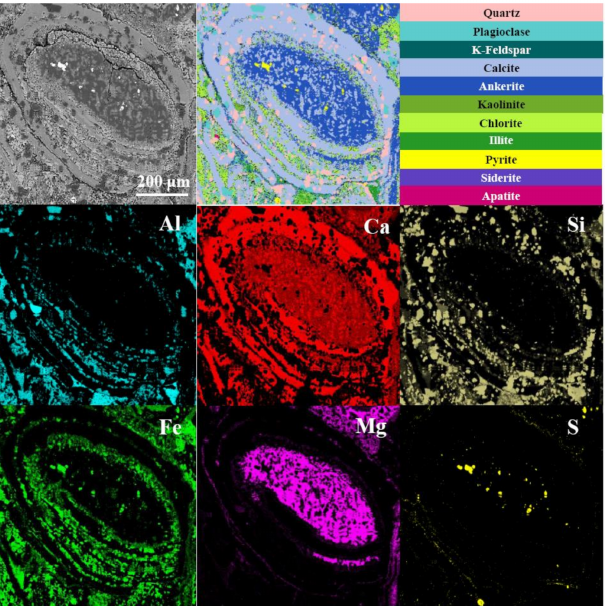
Figure 5. Scanning electron microscope photo and QemScan images of an ostracod filled with ankerite. Color brightness in each map represents relative abundance of its corresponding element. Brighter color indicates higher element content.